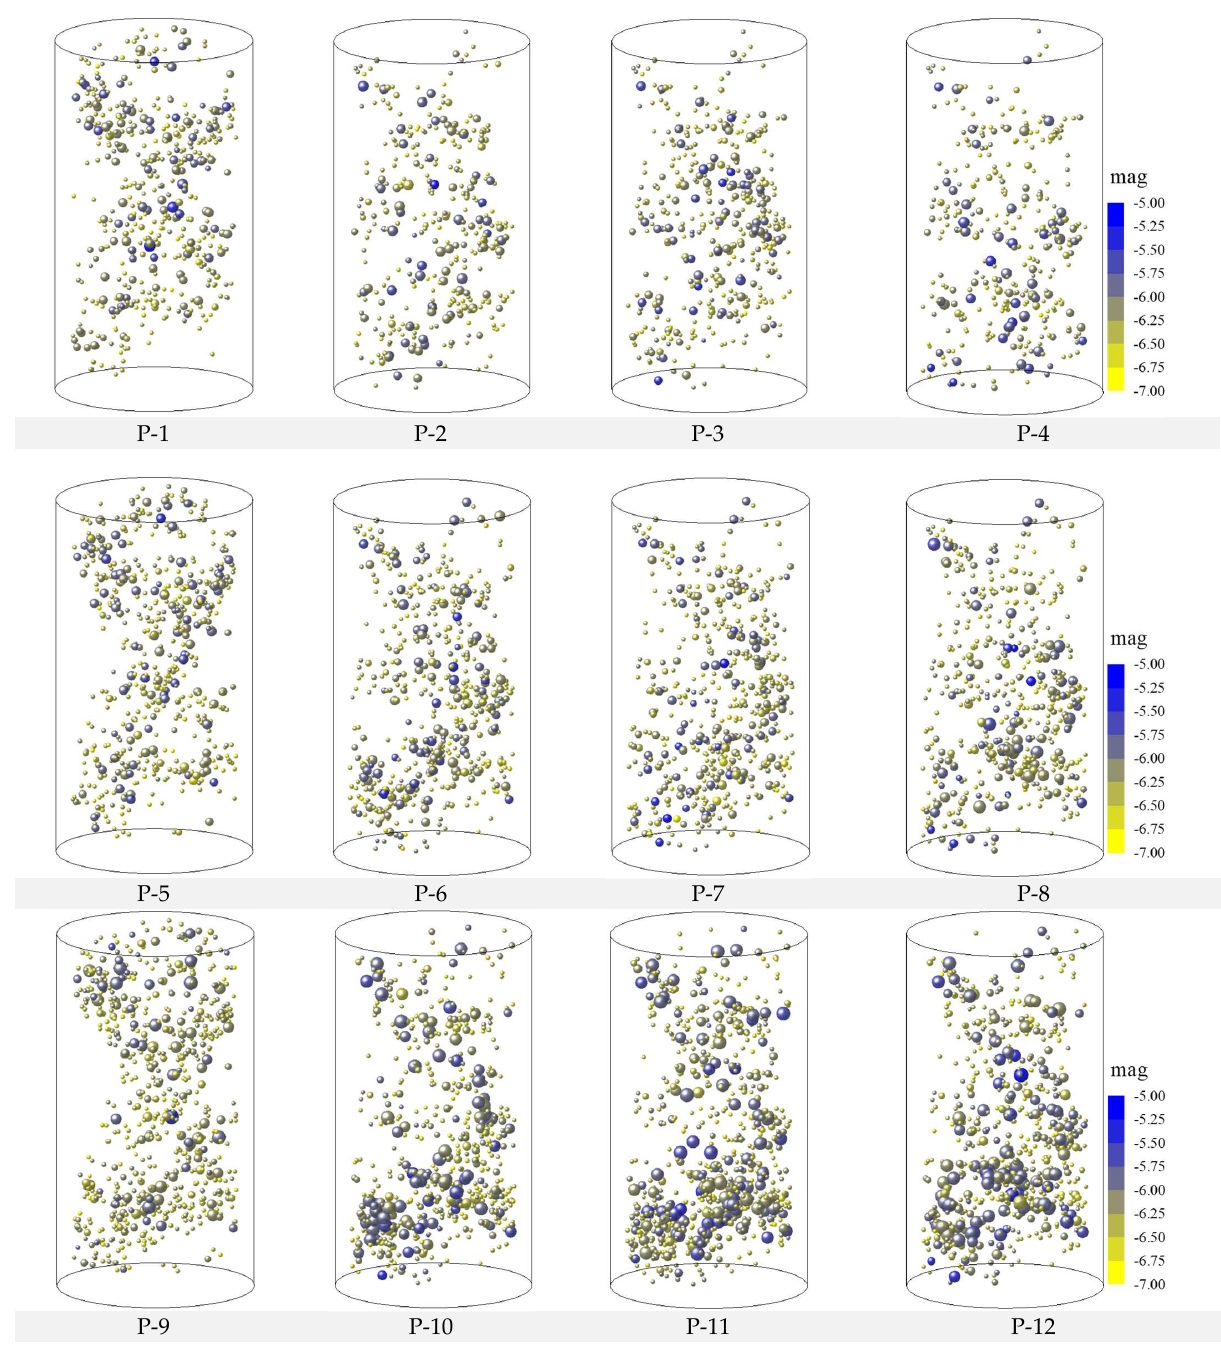
Figure 12. Source distributions of different models at different stages.